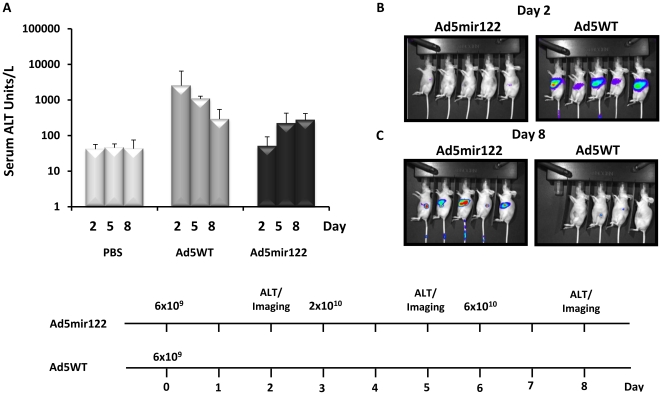
Pharmacodynamics led dose escalation study to determine the optimal treatment dose with Ad5mir122 and Ad5WT in tumour bearing mice.A) Serum Alanine Transaminase (ALT) levels from mice receiving Ad5mir122, Ad5WT or PBS. ALT values for each group are shown at days 2, 5 and 8 (n = 3) after the first injection. Data is presented as ALT units per litre using the equation in the materials and methods. B) Luciferase imaging 2 days after the first injection of Ad5mir122 (left panel) or Ad5WT (right panel). C) Luciferase imaging eight days after the first injection. Mice which received a single injection of Ad5WT are shown in the right panel and mice receiving three injections of Ad5mir122 are shown in the left panel. Images are all presented on the same scale. D) Dosage and treatment schedule for Ad5mir122 and Ad5WT. Viral doses are indicated above each line and include 10% of a Luciferase reporter virus (Ad5mir122luc). All mice were treated with bisphosphonate liposomes at day -1.